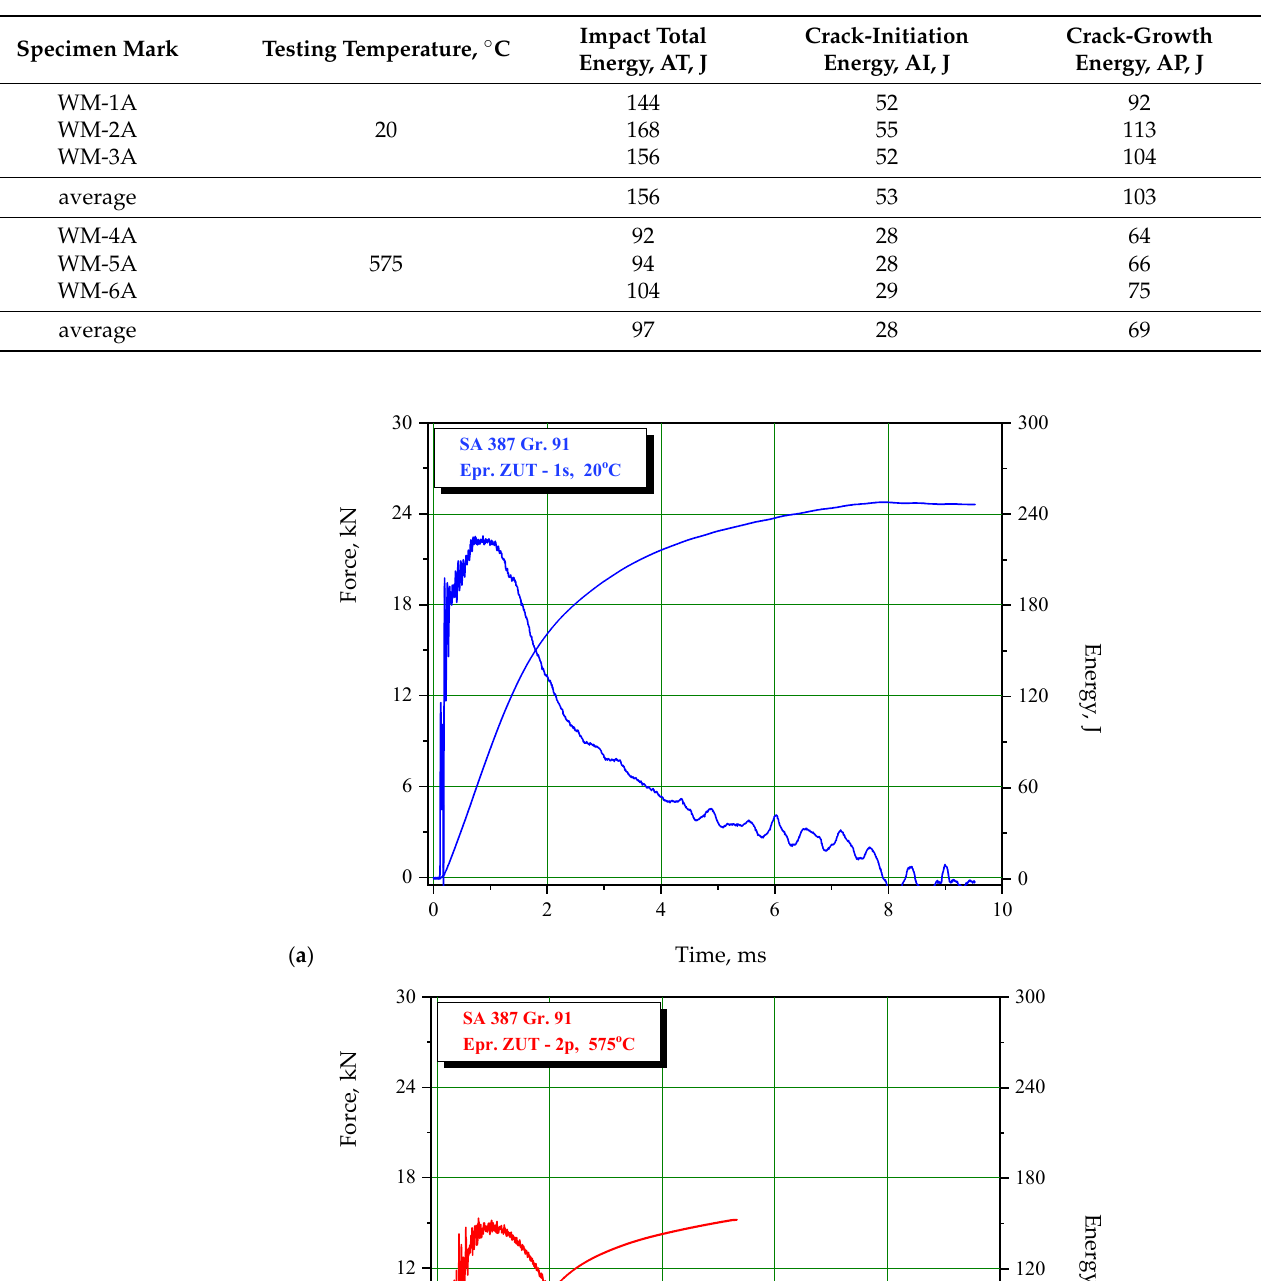
Table 5. Results of Charpy testing—SA 387 Gr. 91 WM.